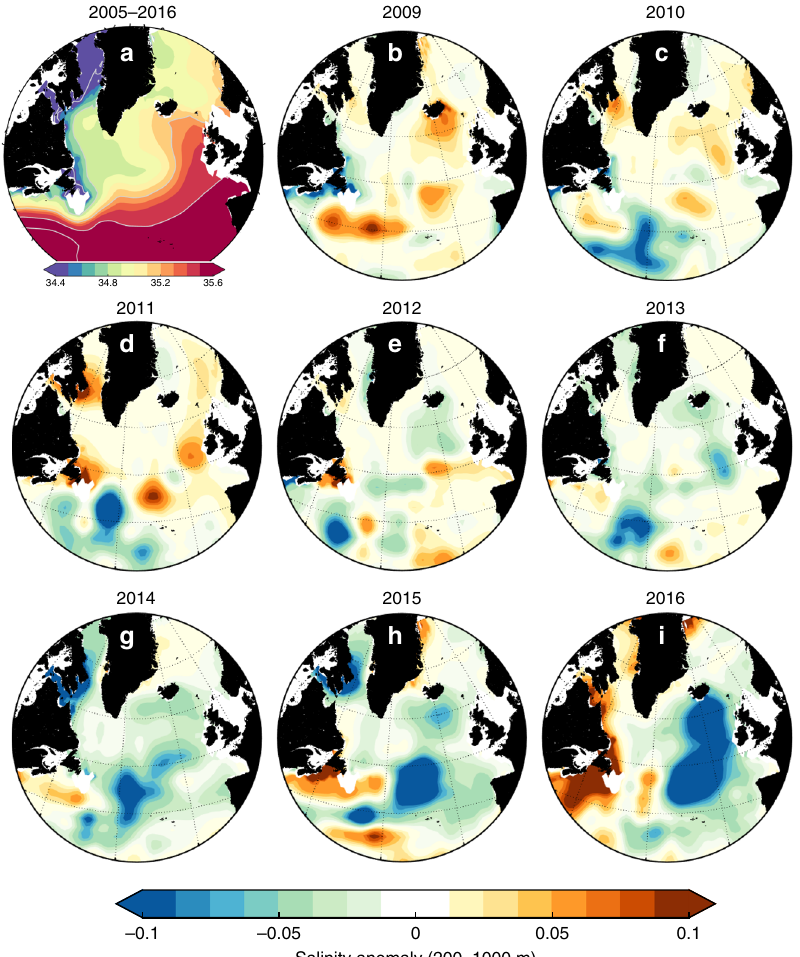
Fig. 3 The mean salinity of the 200 – 1000 m depth zone of the subpolar North Atlantic, and the evolution of anomalies between 2009 and 2016. a mean salinity in the 200 – 1000 m zone for the period of 2005 to 2016, computed from the EN4 dataset. b – i salinity anomalies of the 200 – 1000 m zone in each year from 2009 to 2016, referenced to the 2005 – 2016 mean; warm colours represent higher salinity and cool colours are lower salinity. Note that the colour scale here is different to that shown in Fig. 2. A strong negative salinity anomaly developed in the Newfoundland Basin in 2014 (2 years later than the 0 – 200 m negative anomaly), and by 2016 it had propagated to the Iceland Basin and Rockall Trough. A positive anomaly developed in the North West Atlantic continental shelf and slope region during 2014 –